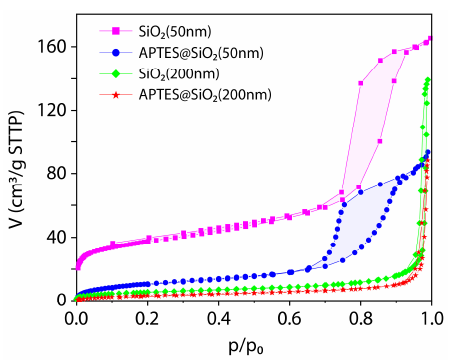
◦ C for the four cases subject of study. Figure 9. N 2 adsorption isotherms at −196 °C for the four cases subject of study. Figure 9. N 2 adsorption isotherms at − 196 Table 1. Porous textural parameters derived from the N 2 adsorption isotherms at − 196 ◦ C and the CO 2 adsorption isotherms at 0 ◦ C of the four SiO 2 NPs of study. A few classical sorbent examples reported in the literature were also